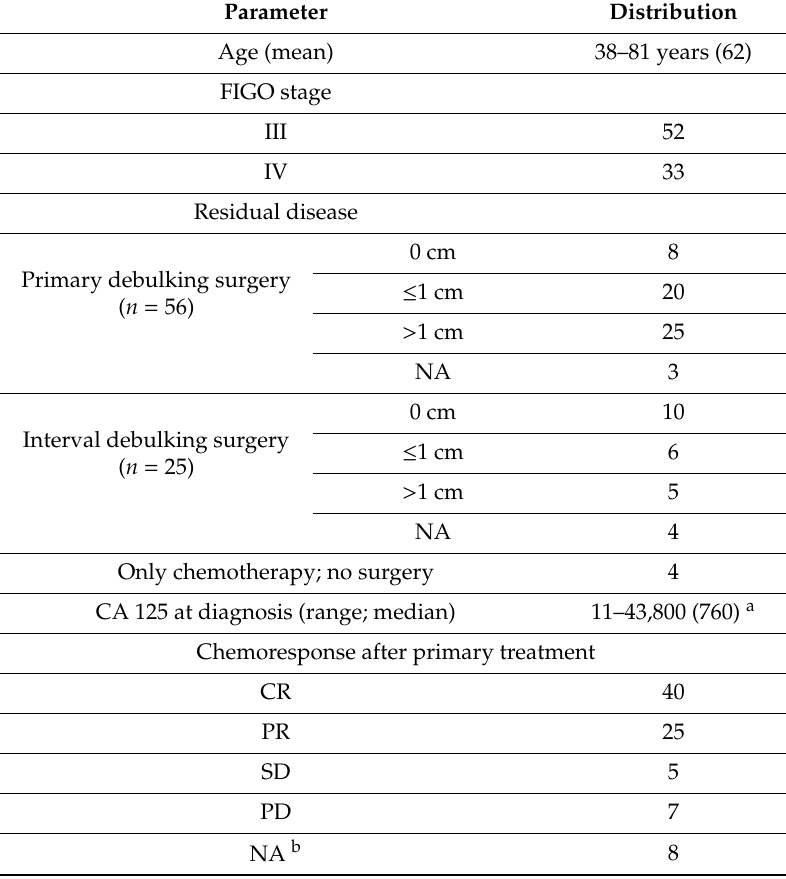
Table 2. Clinicopathologic parameters of the HGSC e ff usion cohort (85